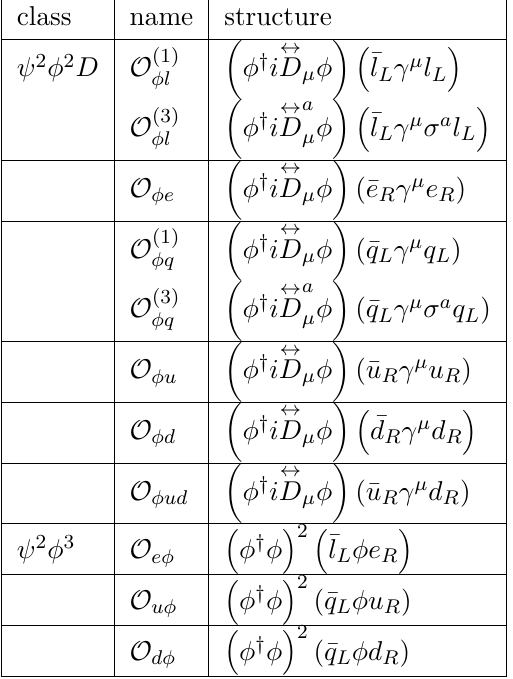
Table 4. Fermion-Higgs operators at dimension-6 in the Warsaw